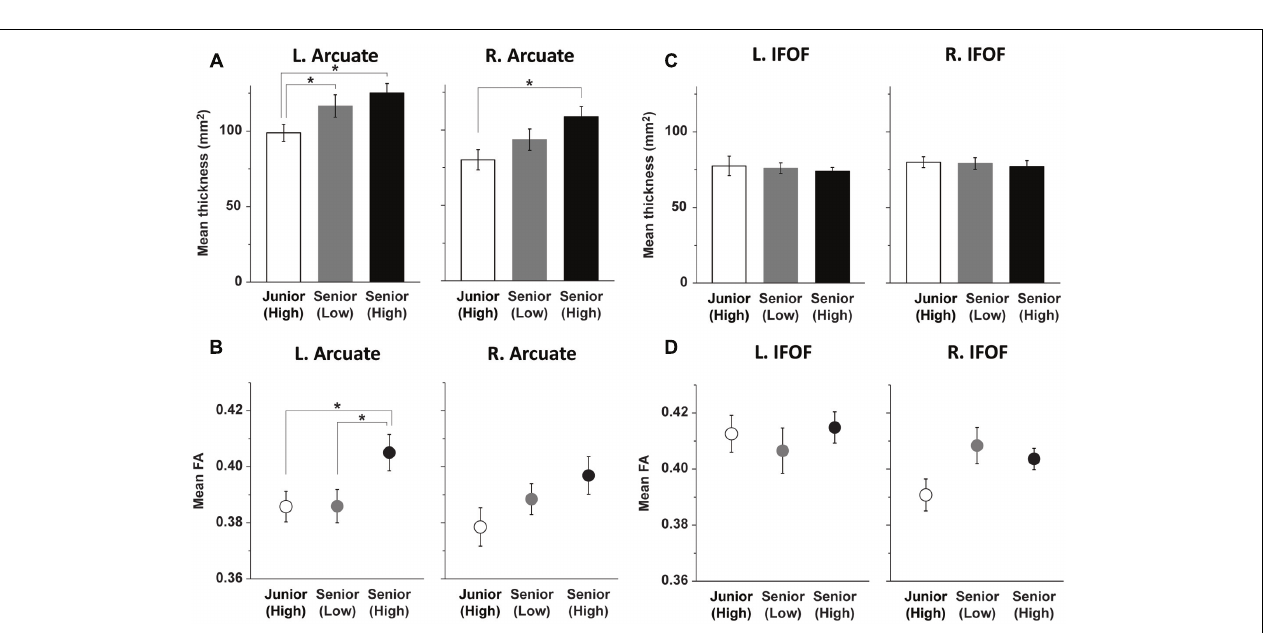
FIGURE 4 | Group differences in the structural properties of the left Arcuate. (A) Age-related group differences on the thickness of the left dorsal pathway. (B) Performance-related group differences on FA in the left dorsal pathway. (C,D) The ventral pathway without group differences. The Junior (High), Senior (Low), and Senior (High) groups are indicated by bars/dots with white, gray, and black shades, respectively. Error bars indicate the SEM for the participants, and asterisks denote statistical differences at P < 0.05 ( post hoc t -test after ANOVA).